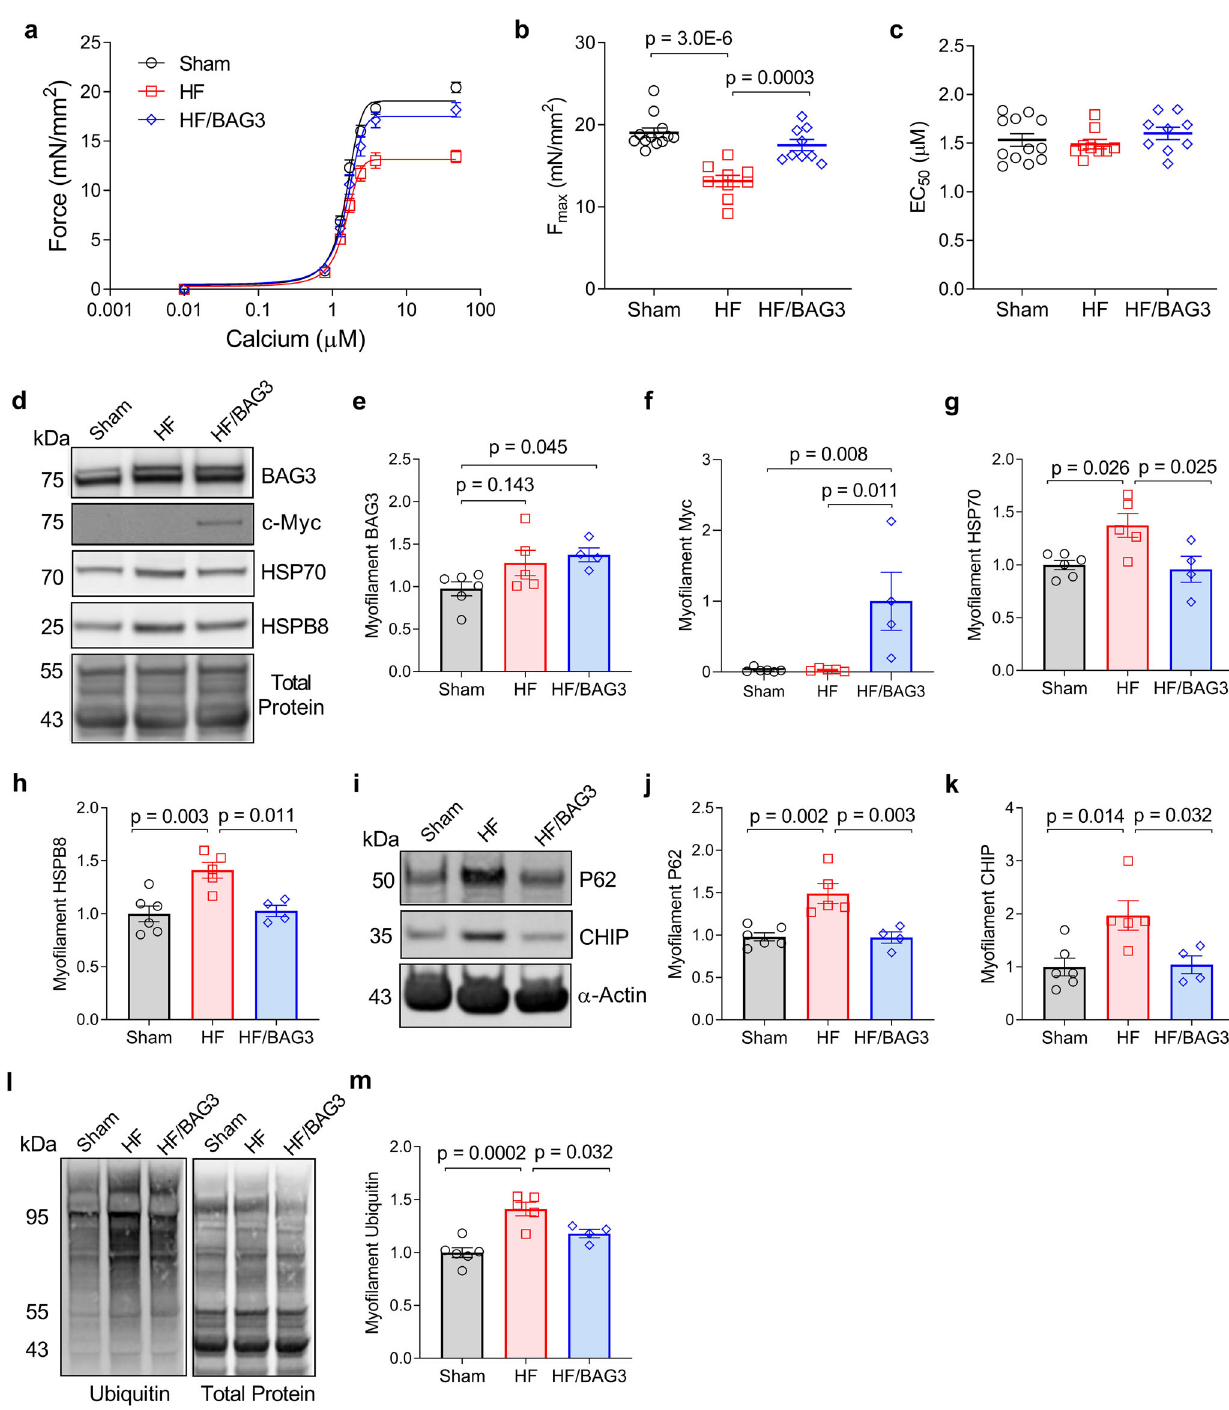
Fig. 7 Increasing BAG3 expression in heart failure restores myo fi lament function and sarcomeric CASA turnover. a Skinned myocyte force-calcium relationship for mouse cardiomyocytes from sham, heart failure (HF), and HF treated with AAV9-BAG3 (HF/BAG3); n = 12 sham from 4 mice, 9 HF from 3 mice, and 9 HF/BAG3 from 3 mice. b , c Summary data for myocyte F max ( b ) and EC 50 ( c ) corresponding to the force-calcium curves in a . d Western blot for myo fi lament BAG3, myc -BAG3, HSP70, and HSPB8 in the sham, HF, and HF/BAG3 mice; images are representative of 6 sham hearts, 5 HF hearts, and 4 HF/BAG3 hearts. e – h BAG3, myc, HSP70, and HSPB8 protein expression normalized to total protein. i Western blot for myo fi lament P62 and CHIP in the sham, HF, and HF/BAG3 mice; images are representative of 6 sham hearts, 5 HF hearts, and 4 HF/BAG3 hearts. j , k P62 and CHIP protein expression normalized to total protein. l Western blot for myo fi lament ubiquitin in the sham, HF, and HF/BAG3 mice; images are representative of 6 sham hearts, 5 HF hearts, and 4 HF/BAG3 hearts. m Myo fi lament ubiquitin normalized to total protein. For all western blots: n = 6 sham, 5 HF, 4 HF/BAG3. All data are presented as mean ± SEM and were analyzed via one-way ANOVA with Tukey post-hoc test for multiple comparisons.